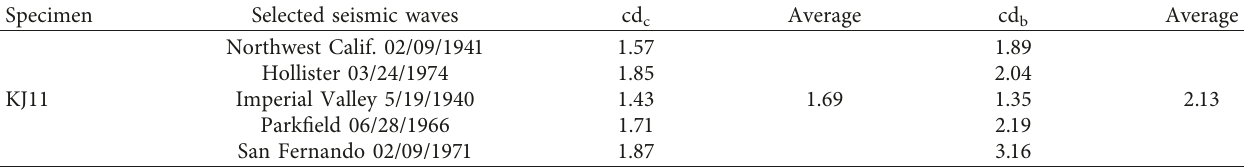
Table 29: Maximum curvature ductility coefficients of beams and columns in model